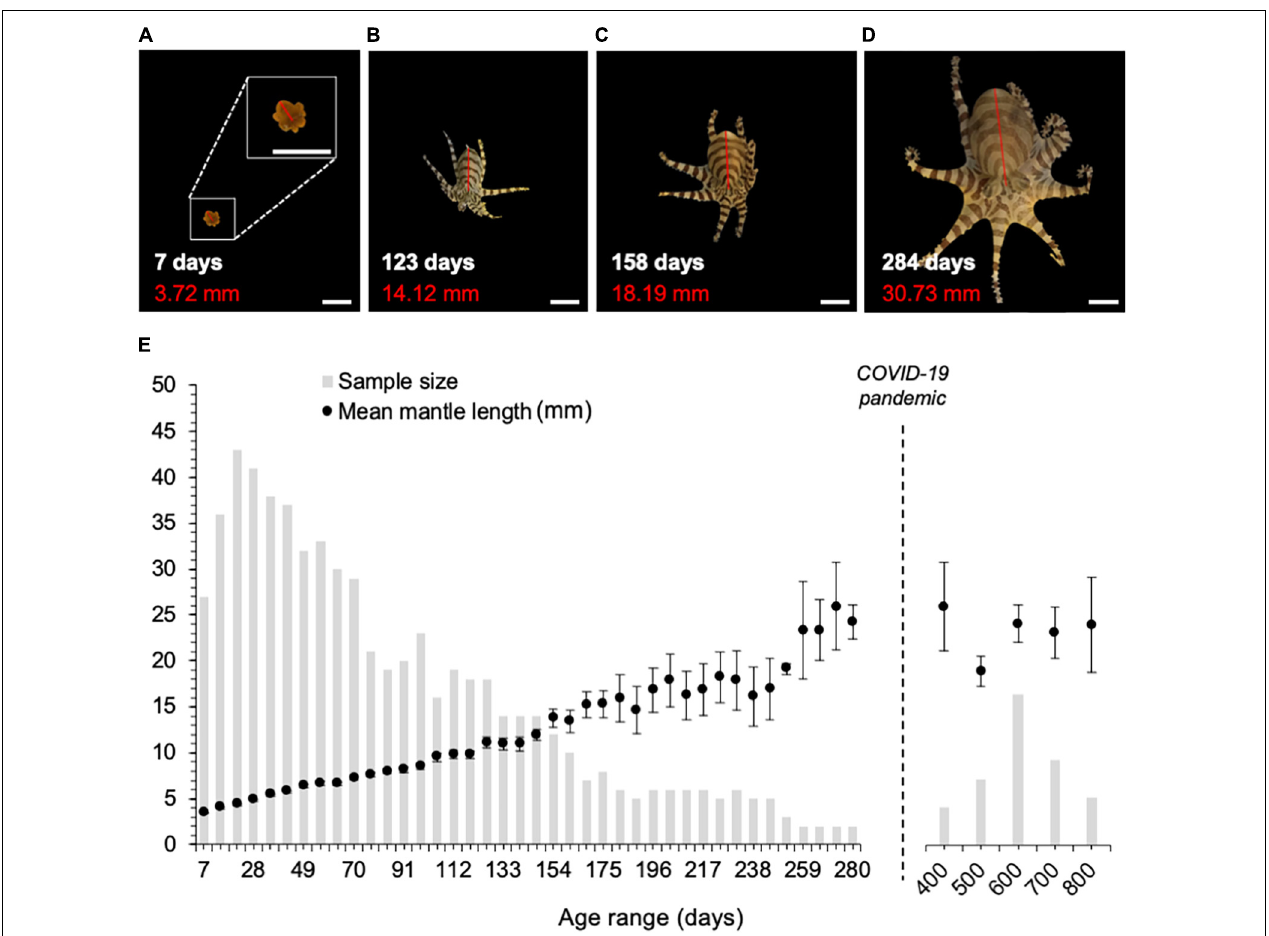
FIGURE 3 | Growth of O. chierchiae over time. (A–D) Images of one individual at 7-, 123-, 158-, and 284-days of age (scale bar: 10 mm). White text is age (in days). Red text is mantle length (in millimeters), depicted by a red line. Inset in (A) shows image at 2x magnification. (E) Average measured mantle length ± SEM over time. For times < 280 days post-hatch, mean mantle lengths were measured for five randomly selected individuals from each clutch (if total cohort size permitted), measured every 7 days from birth. Data points represent pooled average mantle length measured at 7-day increments (i.e., age 0–7, 7–14, 14–21 days, and so on). For 280–800 days, mantle lengths are for 40 randomly selected adult individuals, where the pooled average was calculated for individuals between 280–400, 400–500, 500–600, 600–700, and 700–800 days of age. n , number of mantle length measurements; SEM, standard error of the